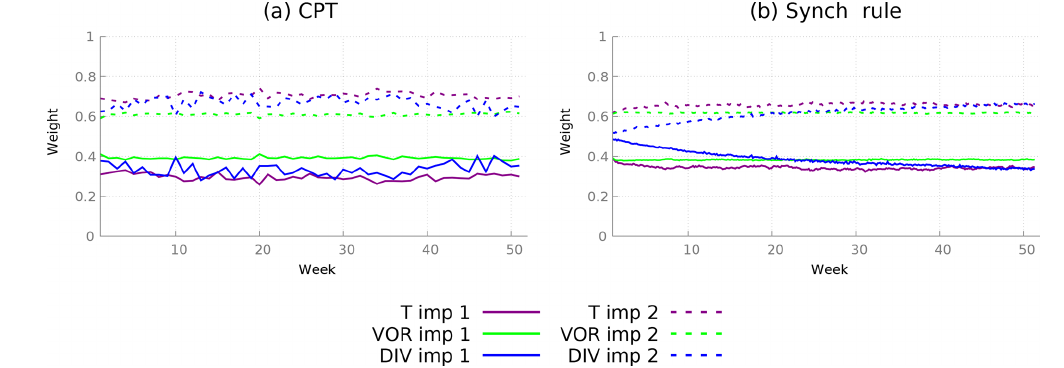
Figure 7. Calculation of weights for a supermodel constructed from two imperfect models using two different training schemes. (a) CPT weights calculated during a training period of 1 week estimated for each week of a year. (b) Weights for the synch rule during a training period of 1 year.